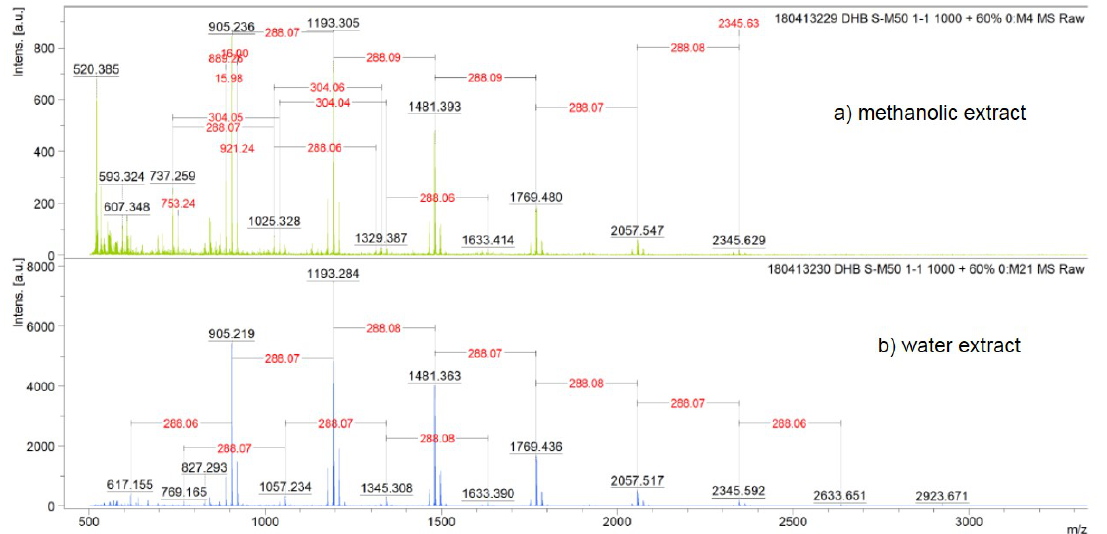
Figure 3. MALDI-TOF positive reflectron mode mass spectra of the condensed tannins from methanolic ( a ) and water ( b ) extracts of Acacia seyal bark.